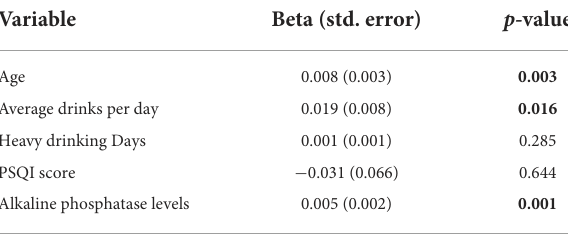
TABLE 4 Multiple linear regression results